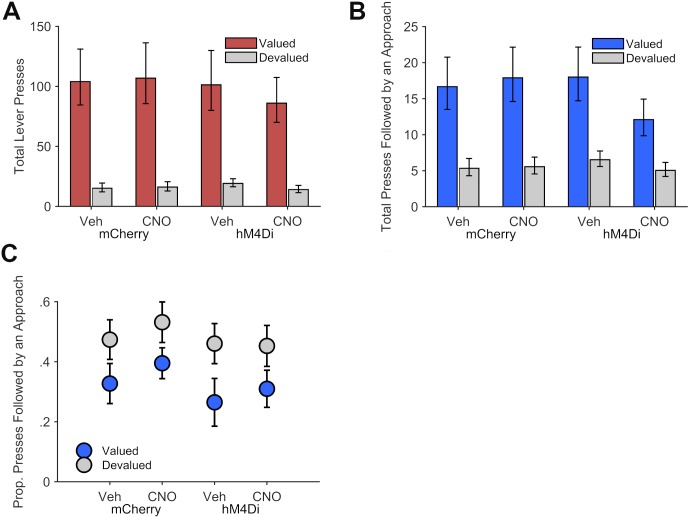
Data from the reinforced phase of reward devaluation testing for rats expressing the inhibitory DREADD hM4Di or mCherry following vehicle or CNO treatment in Experiment 4.(A) Significantly fewer lever presses were performed on the devalued lever compared to the valued lever, t(148) = −5.55, p<0.001, which did not interact with Group or Drug, ps ≥. 095. (B) Similarly, the frequency of presses that were followed by a food-cup approach was lower on the devalued versus the valued lever, t(148) = −5.46, p<0.001, which also did not depend on Group or Drug, ps ≥0. 128. In A-B, error bars represent ±1 standard error of the estimated marginal means from the corresponding fitted generalized linear mixed-effects model. (C) The proportion of lever presses that were followed by a food-cup approach was significantly higher for the devalued versus the valued lever, t(131) = 4.11, p<0.001, which also did not depend on Group or Drug conditions, ps ≥. 679.